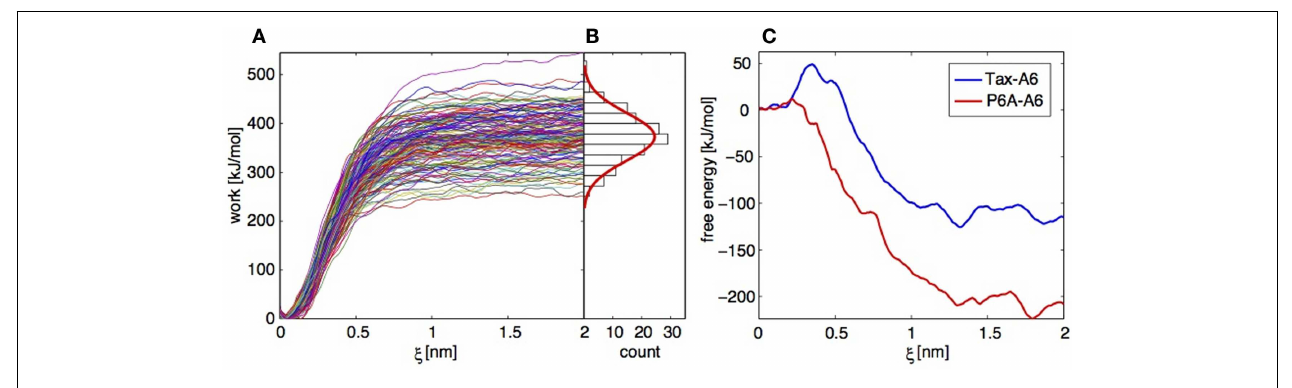
ξ = 2 nm, with a fitted Gaussian distribution. (C) Free energy profiles calculated using the Jarzynski identity and the cumulant expansion